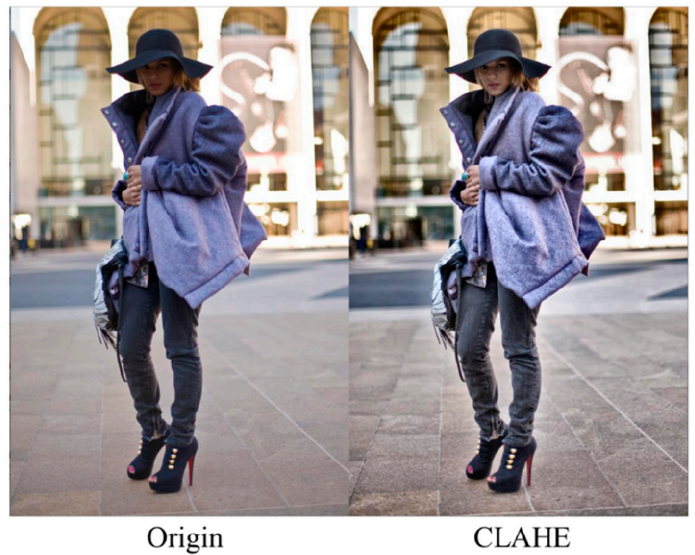
Figure 4. The effect of image pre-processing by CLAHE